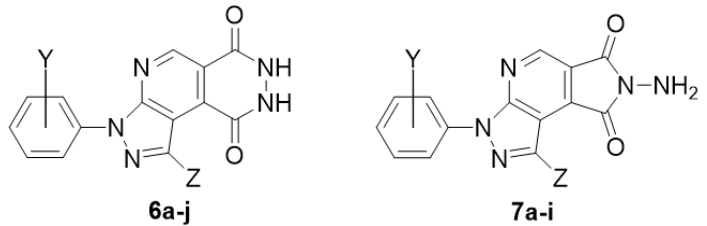
Figure 2. Pyrazolopyridopyridazine diones 6a – j and N -Aminopyrazolopyrrolopyridine diones 7a – i as luminol analogues.